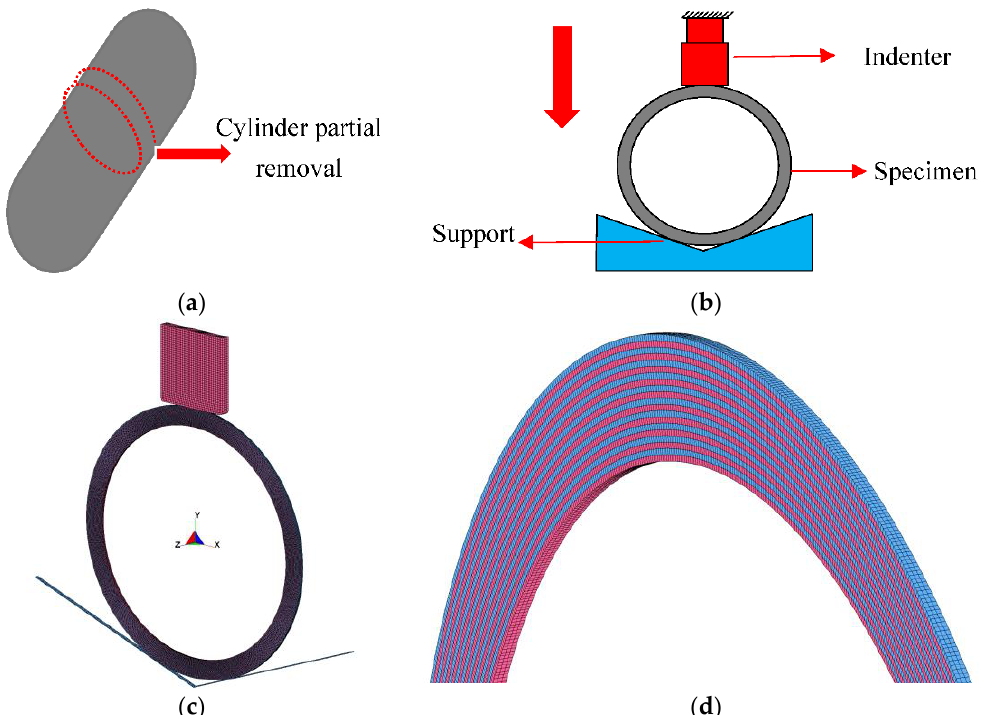
Figure 11. Schematic diagram of simulation analysis for the column part of composite material tank. ( a ) The cutting of the column part of the composite tank; ( b ) the loading experiment on the composite